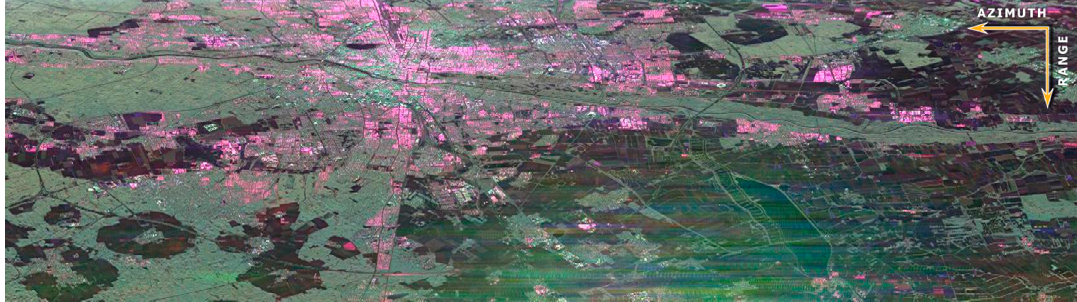
Figure 2. Polarimetric SLC SAR image of the test site in Munich, Germany, 2015 (near range on top). The colors correspond to the channels HH (red), VV (blue) and HV (green). The utilized gulfstream G-III aircraft flew at a nominal altitude of 12.5 km with a swath of 22 km and length of 60 km. The incidence angles range from 25° to 65°. For the specified microwave